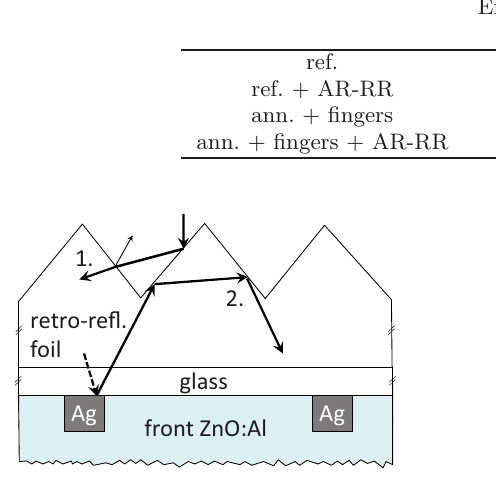
Fig. 4. Illustration of the geometric-optics interaction between a ray of light and the anti-reflective/retroreflective foil. Effect 1: the fraction of incoming light that is not transmitted into the foil upon the first incidence will hit a second facet, resulting in a higher fraction of transmitted light. Effect 2: light reflected out of the cell, in particular at the Ag fingers, is redirected back towards the active layers of the cell via a double rebound of the light beam at the textured-foil/air interface.